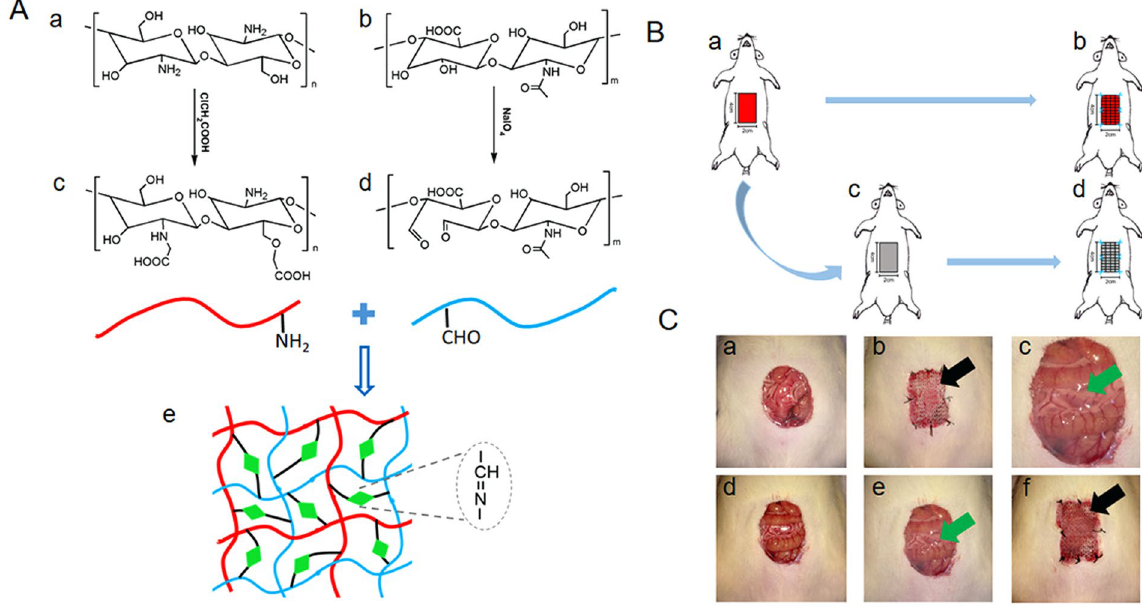
Figure 1. ( A ) Schematic illustration of preparation of CS/HA hydrogel via Schiff’s base reaction. Chemical structures of chitosan (CS) (a), carboxymethyl chitosan (NOCC) (c), hyaluronic acid (HA) (b), and aldehyde hyaluronic acid (A-HA) (d). ( B ) Schematic diagram of the animal model and the experimental procedure: (a) the abdominal wall defect model, (b) the Control group, (c) fibrin gel or CS/HA hydrogel employed over the defect, (d) the Fibrin gel or CS/HA hydrogel group. ( C ) Gross observation: (a,d) the established defect wound, (b) the Control group (black arrow: PP mesh), (c,e) the employed fibrin gel or CS/HA hydrogel (green arrow: fibrin gel or CS/HA hydrogel), (f) the Fibrin gel or CS/HA hydrogel